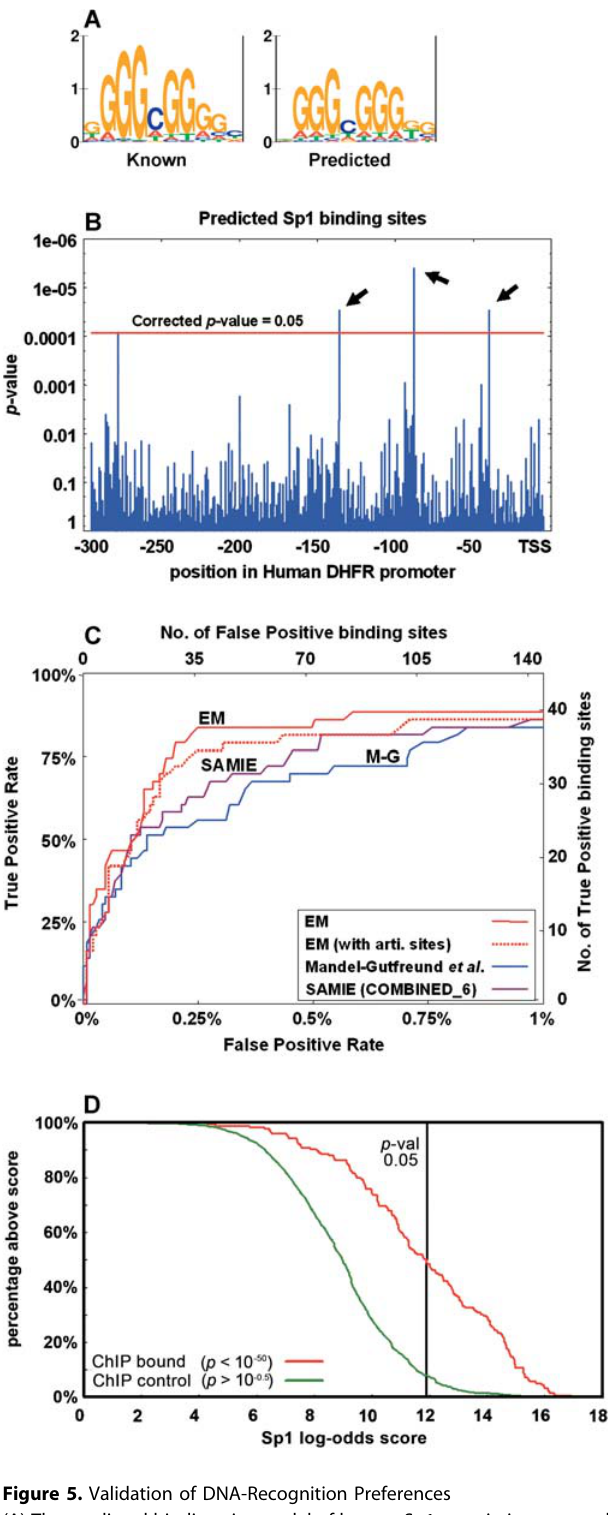
Figure 5. Validation of DNA-Recognition Preferences (A) The predicted binding site model of human Sp1 protein is compared to its known site (matrix V$SP1_Q6 from TRANSFAC [2], based on 108 aligned binding sites). To prevent bias by known Sp1 sites in our training data, the set of DNA-recognition preferences was estimated from the TRANSFAC data after removing all Sp1 sites. (B) Scanning the 300-bp-long promoter of human dihydrofolate reductase (DHFR) by the predicted Sp1 binding model. The p -value of each potential binding site is shown ( y -axis). Four positions achieved